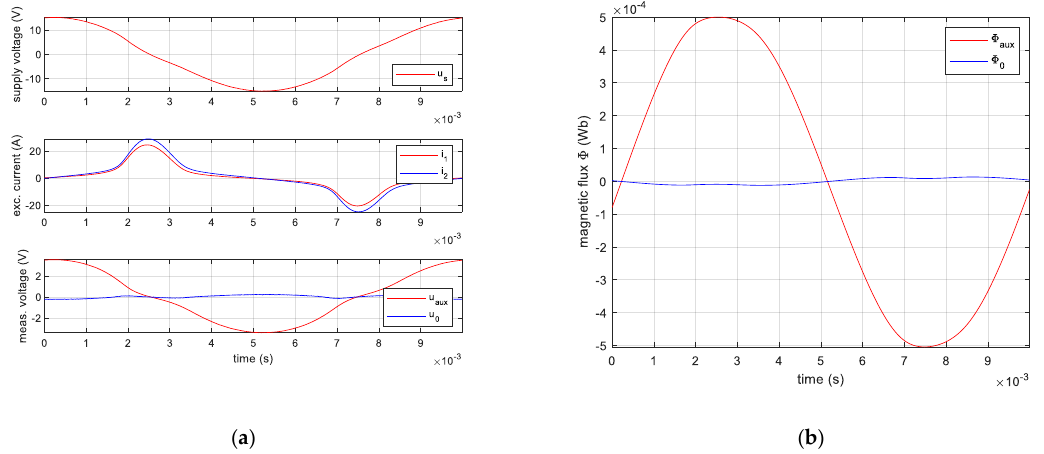
Figure 5. Waveforms of the T2 supplied with C and A windings: ( a ) measured supply voltage u s , excitation currents i 1 (C) and i 2 (A), auxiliary coil voltage u aux (AUX1) and zero coil voltage u 0 (B); ( b ) magnetic flux of the auxiliary coil Φ aux (AUX1) and magnetic flux of the zero coil Φ 0 (B).